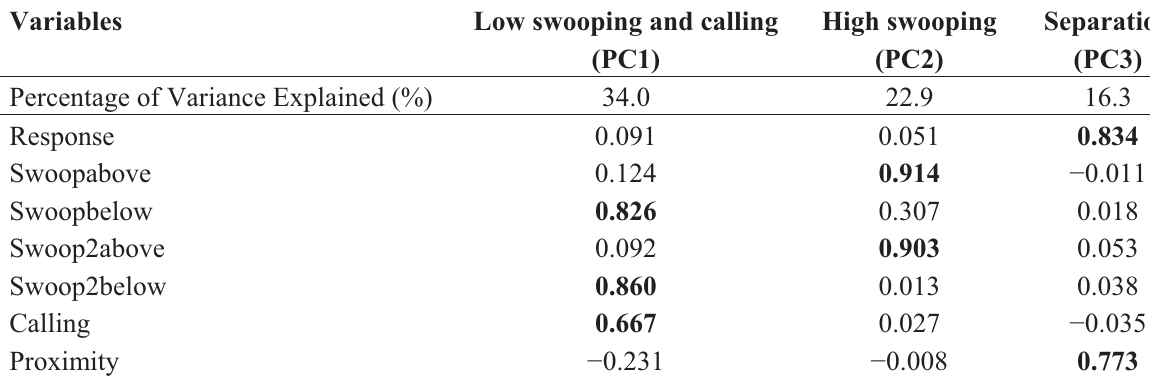
Table 1. Component scores derived from a rotated principal component (PC) matrix of seven behavioural variables measured to characterise lapwing defence. Emboldened values indicate component scores of a magnitude (cid:2)0.60, which were used to interpret the principal